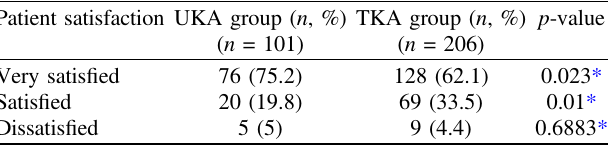
Table 3. Comparison of patient satisfaction.